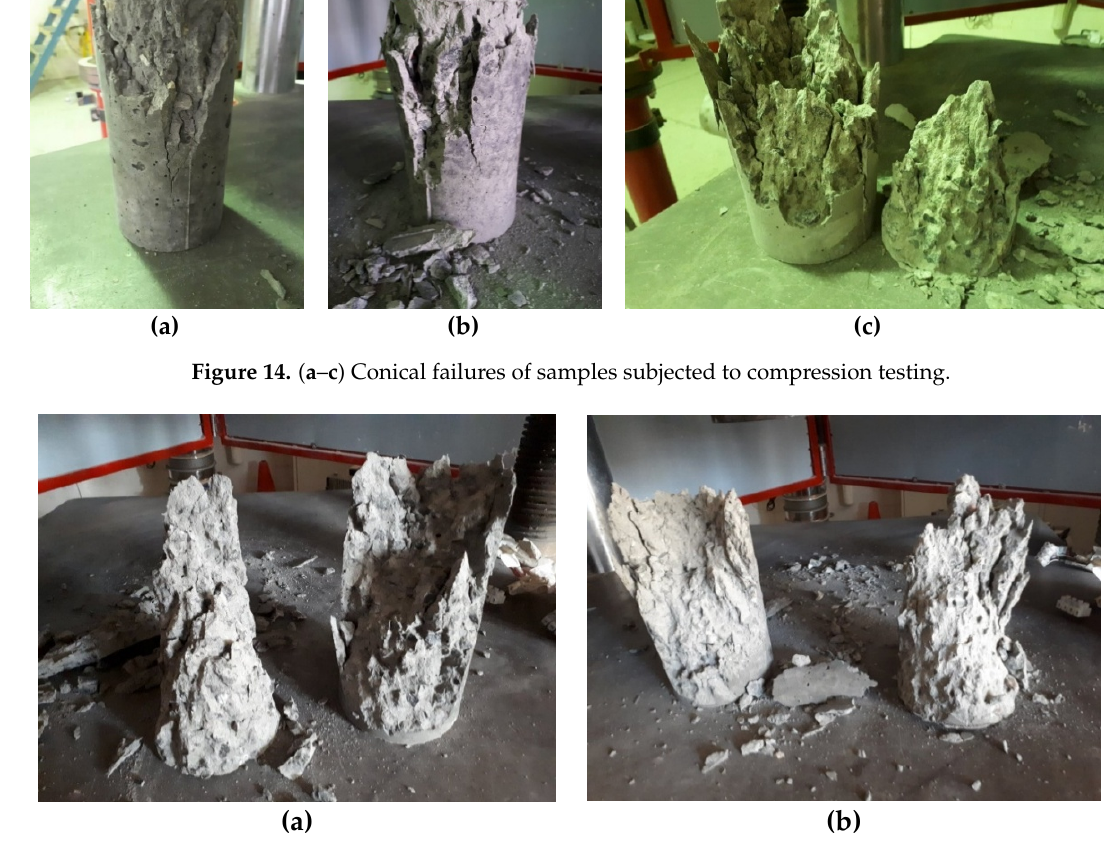
(b) Figure 16. (a,b) Vertical shear failure of samples subjected to compression testing. Tensile and flexural bending tests failed through the middle as expected for the types of tests being conducted with no tests possessing a failure pattern out of the ordinary. Figure 17 shows the failure pattern of samples subjected to tensile testing, while Figure 18 shows the failure pattern for samples subjected to flexural testing. (a) (b) Figure 17. (a,b) Failure pattern for samples subjected to tension testing.